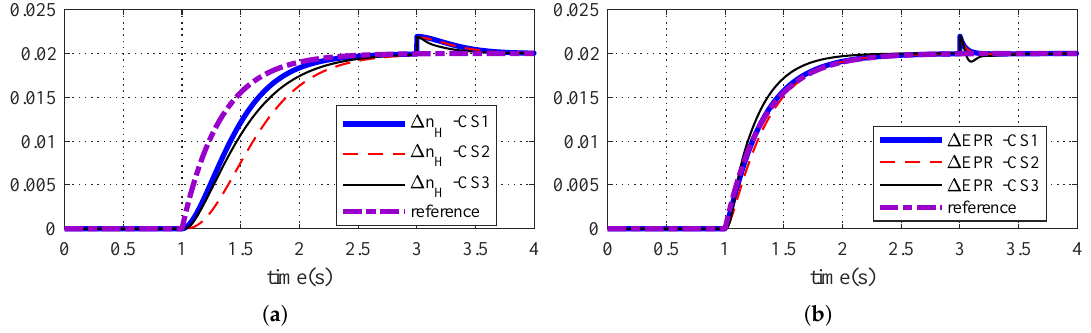
Figure 5. Output response for the exponential reference. ( a ) ∆ n H tracking curve; ( b ) ∆ EPR tracking curve.